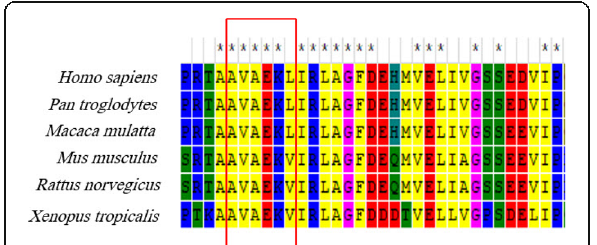
Fig. 3 The modified region (5 deleted amino acids shown in the red box and the folowing 20 residues that are changed due to the frameshift mutation) is located in a highly conserved region among